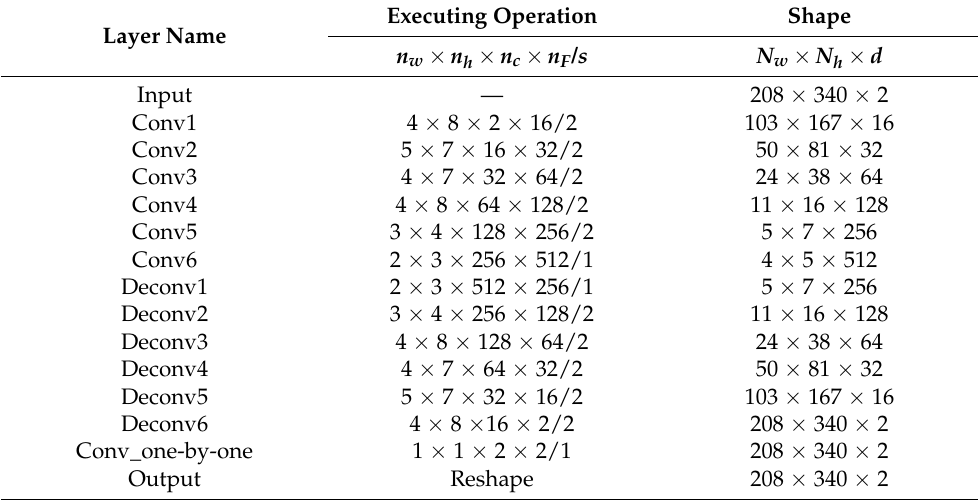
Table 1. Model Parameters of convolutional